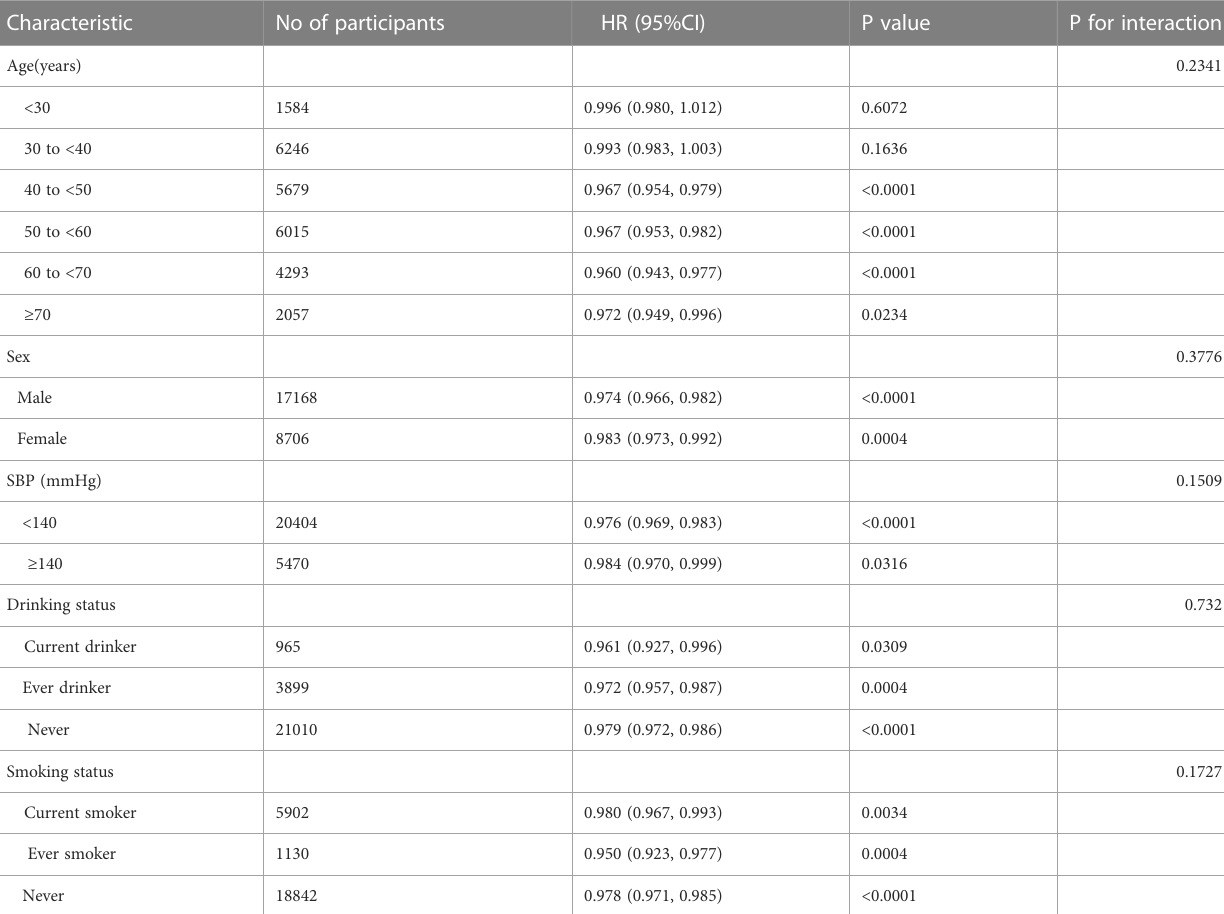
TABLE 8 Strati fi ed associations between BMI and reversion to normoglycemia in patients with IFG by age, sex, SBP, DBP, smoking status, and drinking status.